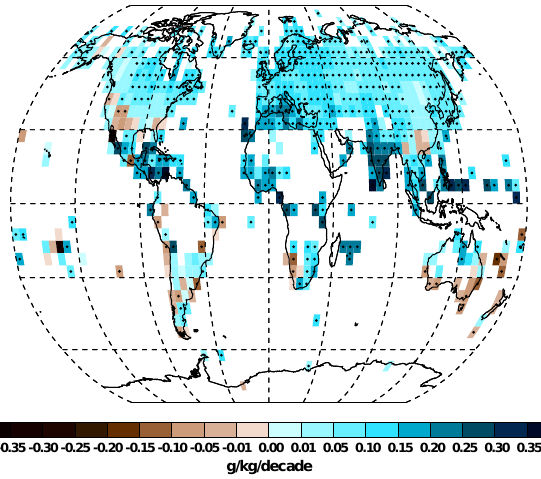
Fig. 11. Decadal trends in specific humidity for HadISDH over 1973–2012. Trends are fitted and confidence assigned as described in Fig. 9. Note non-linear colour bars.